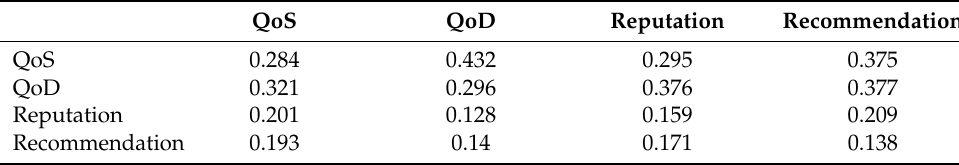
Table 8. Normalised FCM for Scenario 1.